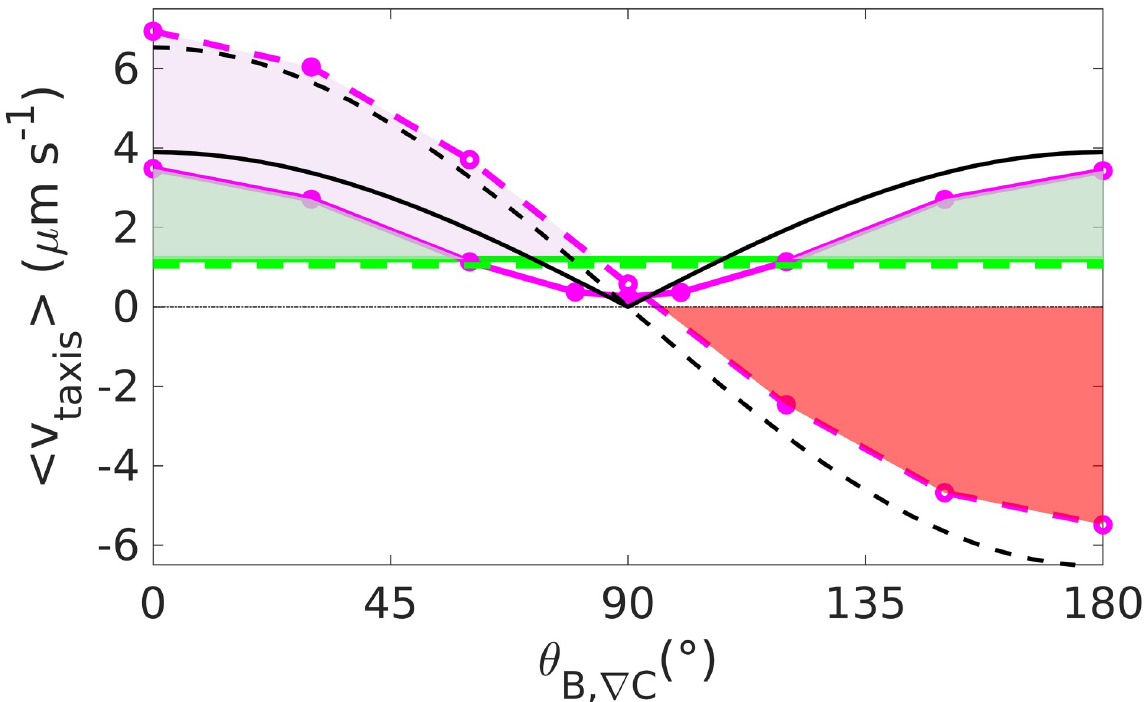
Fig 4. Chemotaxis with magnetic torque. Taxis velocity up the gradient for run and reverse (solid lines) and run and tumble (dotted lines) at B = 0 μ T (green line) and B = 50 μ T (purple line). In black, the theoretical predictions. In the presence of a field at a small angle θ B , r C relative to the concentration gradient, run and tumble performs better than run and reverse (the pink area shows the gap between the tumble curve and the reverse curve). Reverse plus magnetic field outperforms reverse without the field except for angles around 90˚ (the green area shows the gap between the curves with and without field for reverse). Tumble with field, on the other hand, hinders chemotaxis at large angles (the red area shows the gap between zero velocity and the tumble